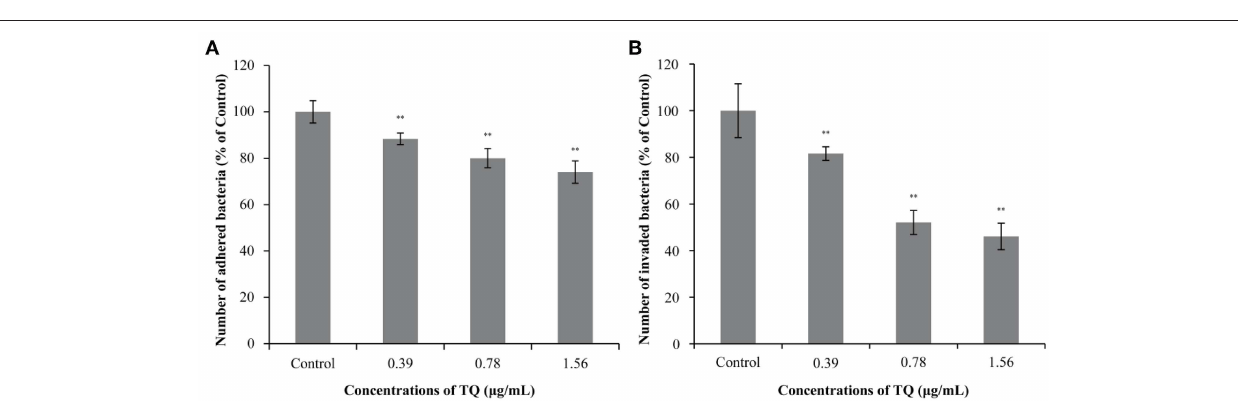
FIGURE 5 | Effects of thymoquinone (TQ) on the ability of Listeria monocytogenes ATCC 19115 to adhere to (A) and invade (B) Caco-2 cells. Bars indicate the standard deviation ( n = 3). ** P <